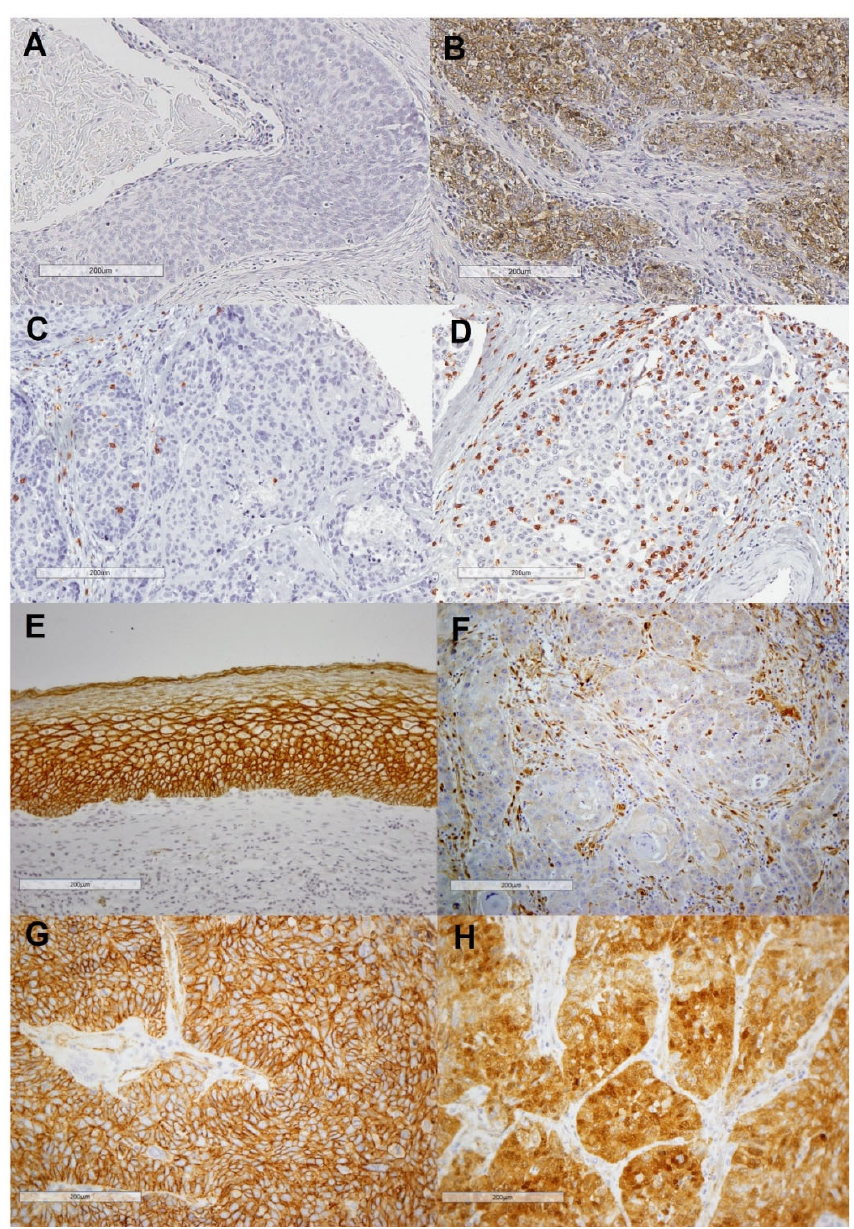
Figure 1. Representative examples of negative ( A ) and positive ( B ) PD-L1 expression; low ( C ) and high ( D ) CD8+ T-cells infiltration; expression of β -catenin in normal epithelium ( E ) and absence of expression of β -catenin ( F ), membrane expression of β -catenin ( G ), and nuclear expression of β -catenin ( H ) in carcinomas. Original magnification ×